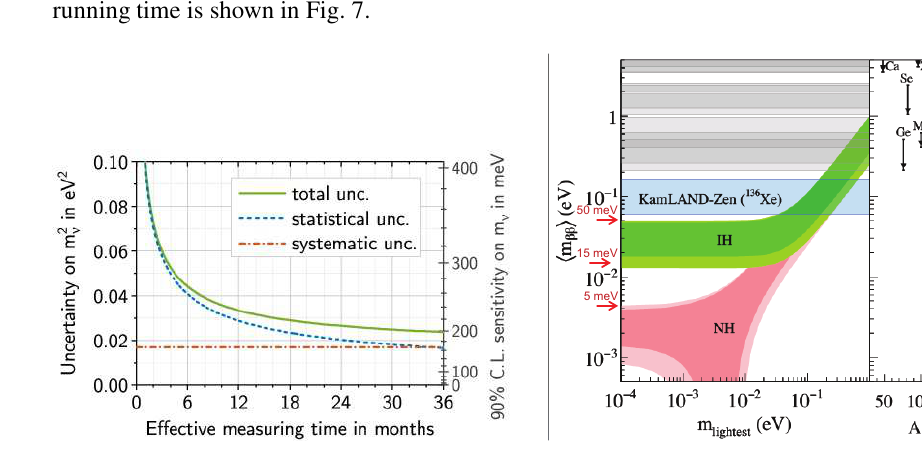
Figure 7. Sensitivity of the KATRIN experiment as a function of the running time. Left vertical axis: 1 σ statistical, systematic and total uncertainties of m 2 . Right vertical axis: sensitivity (90% CL) to ν m ν [16].